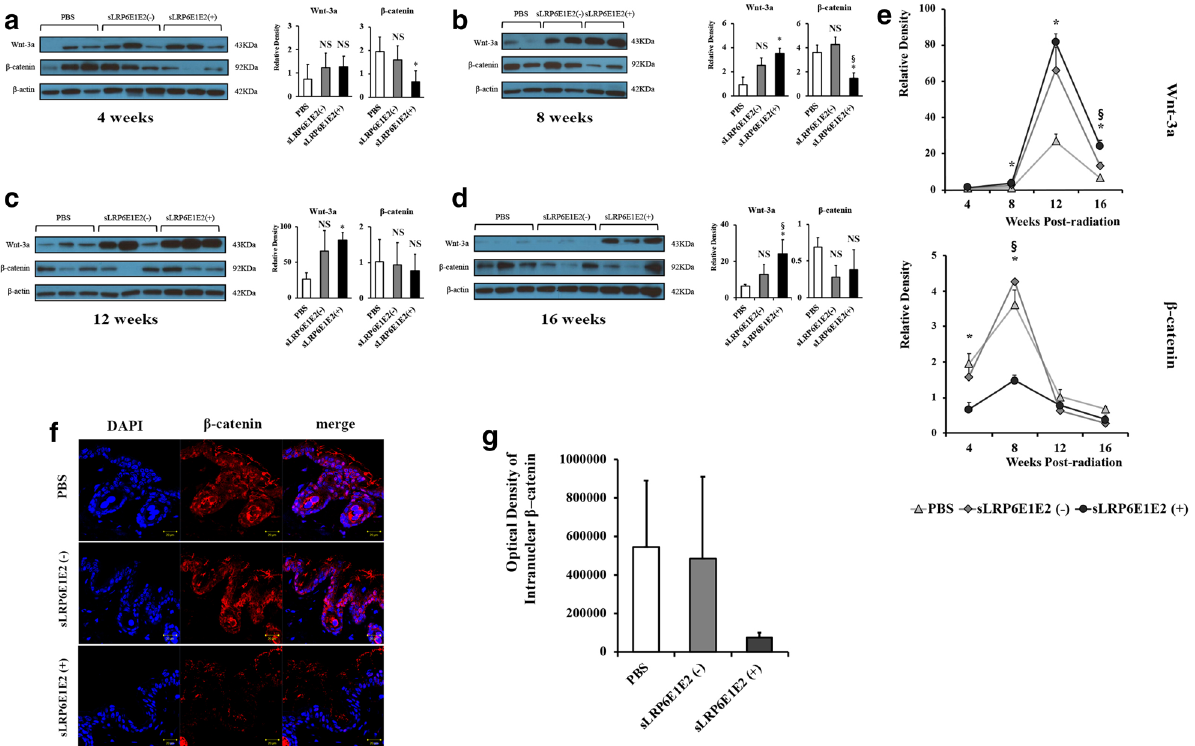
Figure 4. Inhibition of Wnt/β-catenin pathway by decoy Wnt receptor sLRP6E1E2 in irradiated mouse. Wnt-3a and β-catenin were detected by western blot after transduction with dE1-k35/sLRP6E1E2 or dE1-k35. The blots were from one gel and were then probed with different antibodies one at a time. Each blot was taken from one mouse. β-actin was used as an internal standard. *p < 0.05 vs PBS. § p < 0.05 vs sLRP6E1E2 (–). ( a – d ) Gels/ blots and quantification at post-radiation 4, 8, 12, and 16 weeks, respectively. ( e ) Relative density of Wnt-3a and β-catenin compared to that of control protein as detected using densitometry at various post-radiation time points ( a – d ). ( f ) Cells were labeled with anti- β-catenin to test intranuclear translocation at 8 weeks post-radiation. ( g ) The expression levels of intranuclear β-catenin were assessed semi-quantitatively using MetaMorph imaging analysis